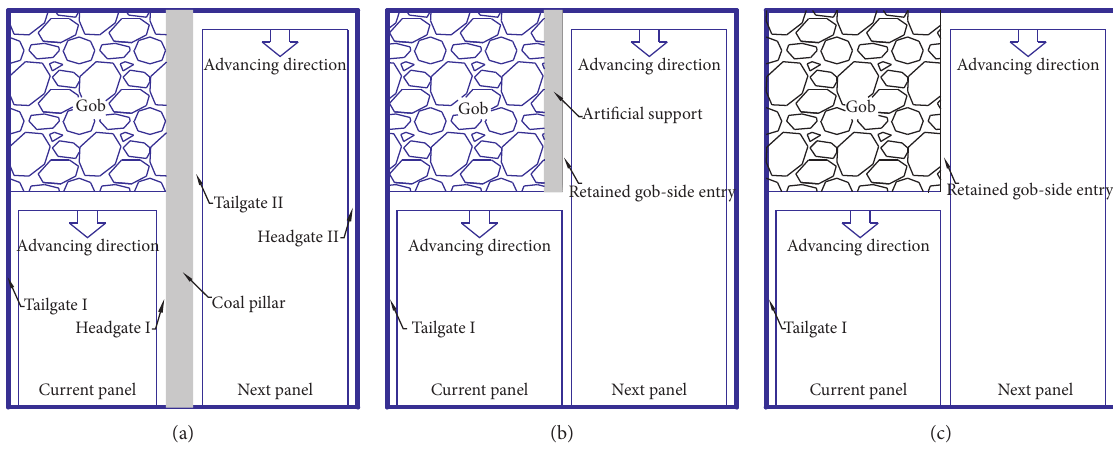
Figure 1: Typical longwall mining scheme. (a) Coal pillar. (b) Artificial support. (c)